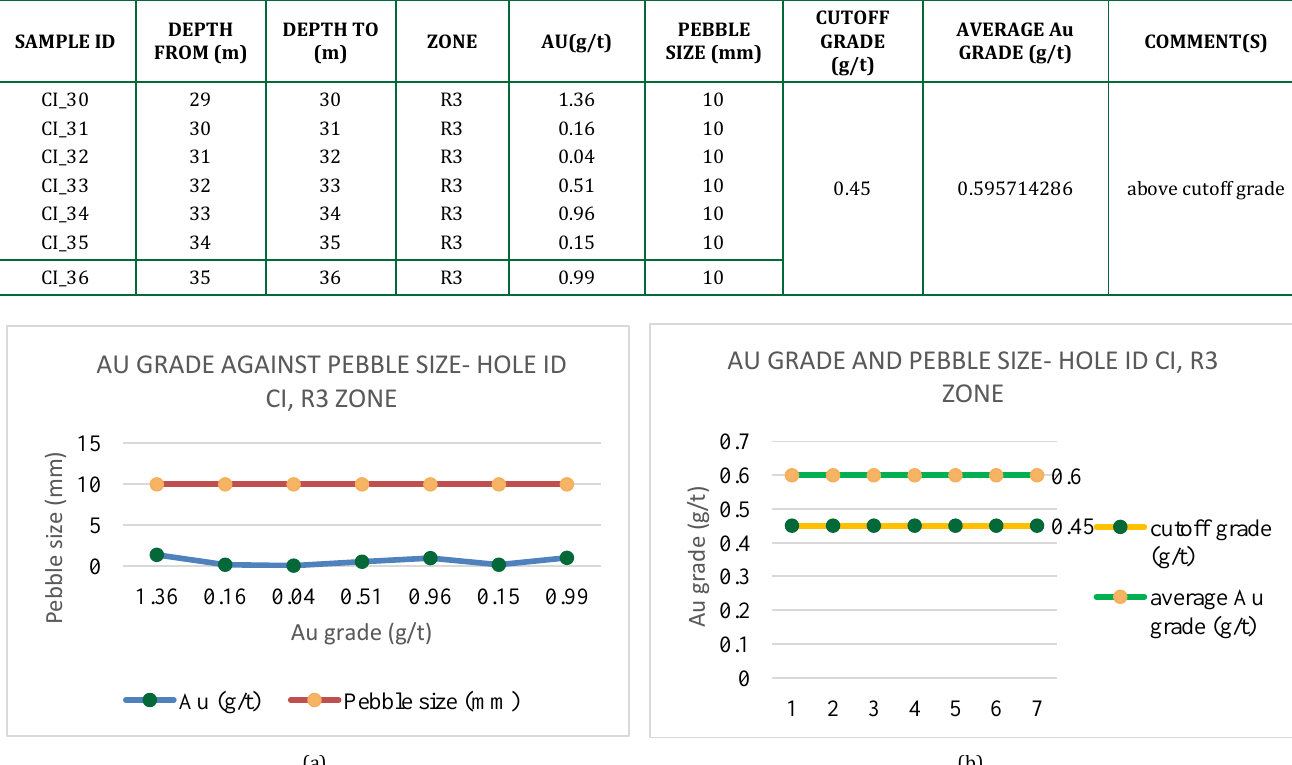
Figure 4: (a) Au grade against Pebble size - Hole ID CI, A3 Zone; (b) Cutoff grade against Average Au grade-Hole ID CI, A3 Zone